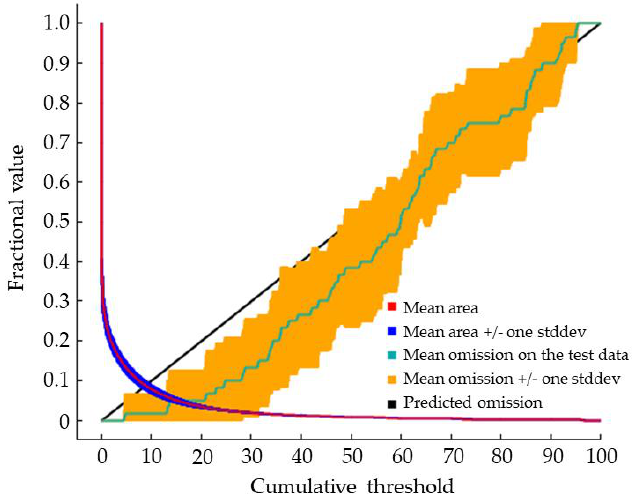
Figure 2. Output of the predictive accuracy of the maximum entropy